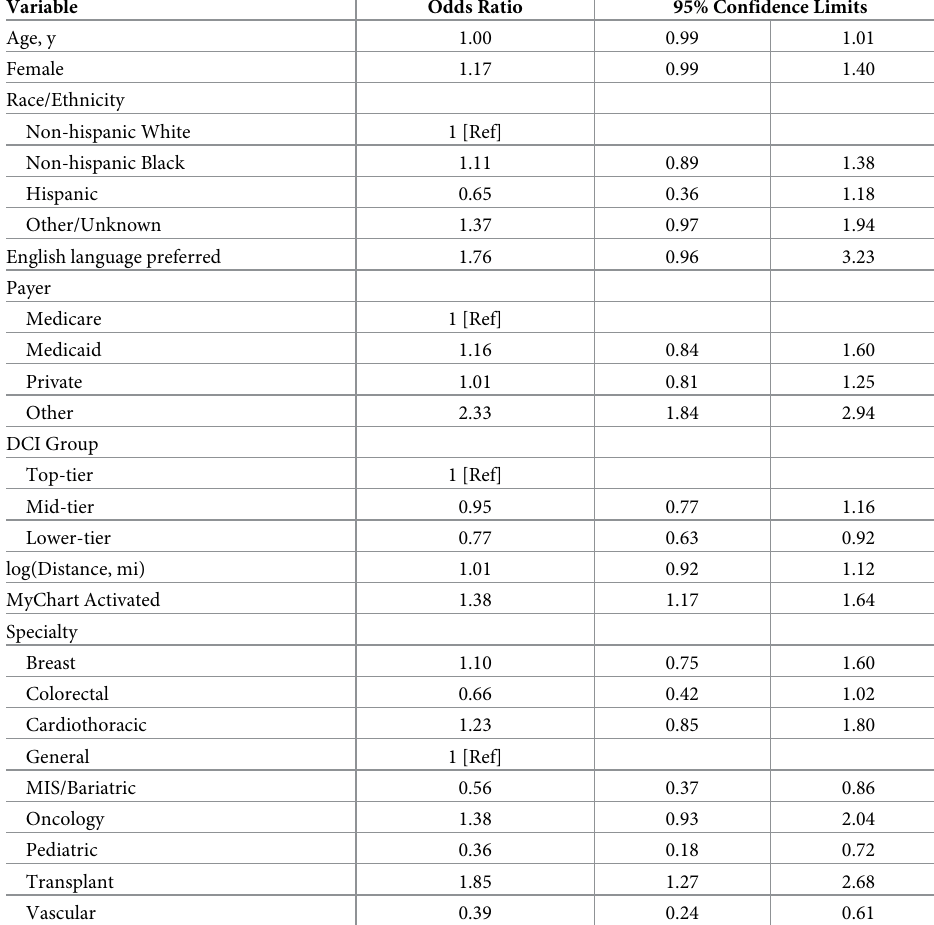
Table 2. Patient characteristics associated with a telemedicine visit during COVID-19, compared to pre-COVID in-person